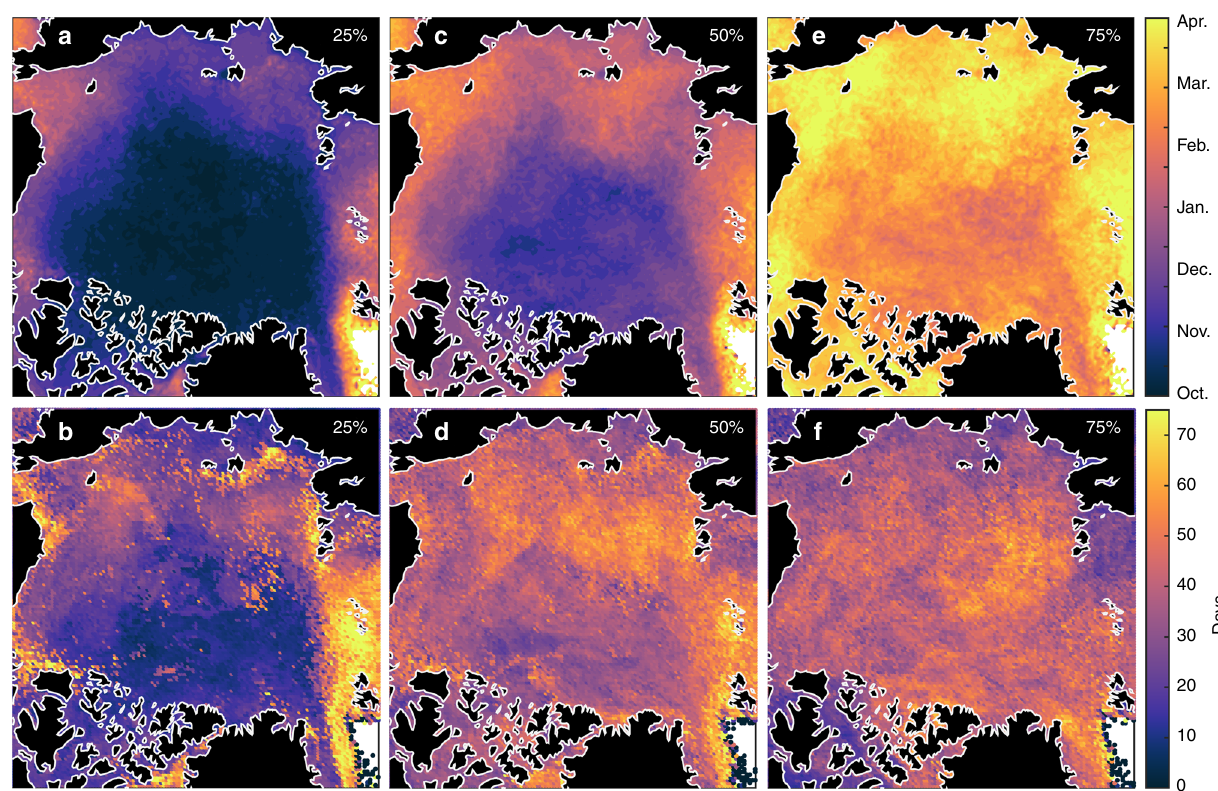
Fig. 6 Dates of when different proportions the snowpack are established. The 1979 – 2016 average dates on which: a 25%, c 50%, and e 75% of the snow cover is established. The standard deviation (days) of the 1979 – 2016 dates for the corresponding b 25%, d 50%, and f 75% snow depth thresholds. The standard deviation indicates which regions are susceptible to low (Central Arctic) and high (East Greenland and Barents seas) variability in snow depth conditions due to cyclone activity, the timing of sea ice freeze-up, and sea ice